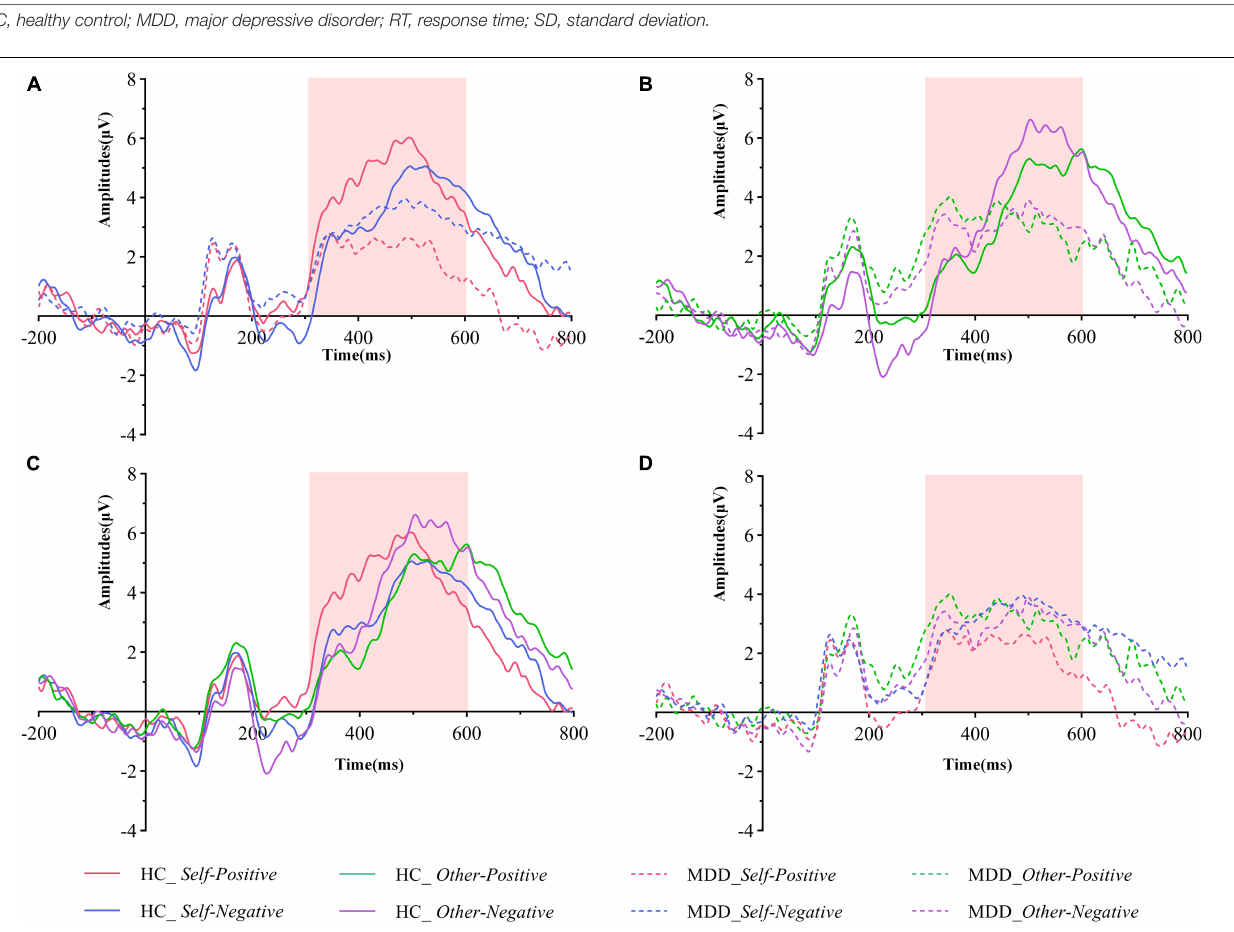
In addition, there are broadly positive correlations among go- P3 amplitudes under different conditions ( r = 0.37–0.64, all p <